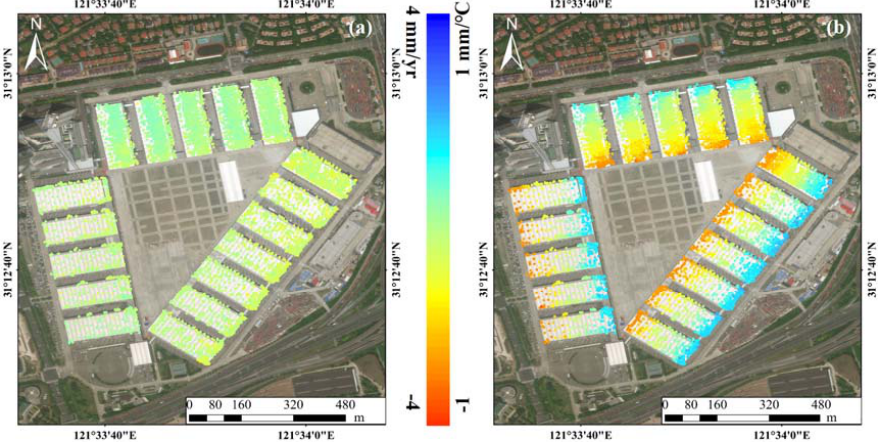
Figure 12. The (a) trend deformation and (b) thermal dilation of the SNIEC.